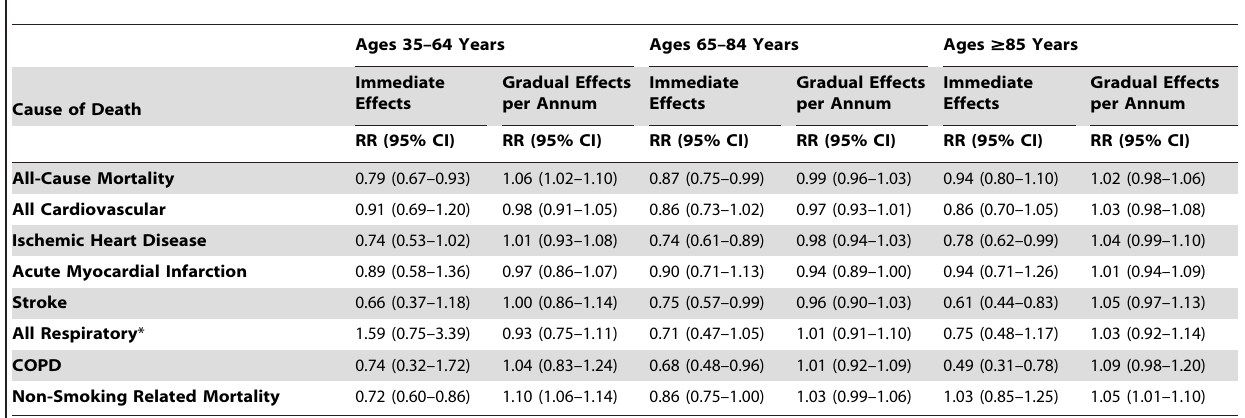
Table 2. Multivariate Analysis { of Post-Ban Effects on Mortality Rates by Age Category ` , Republic of Ireland,